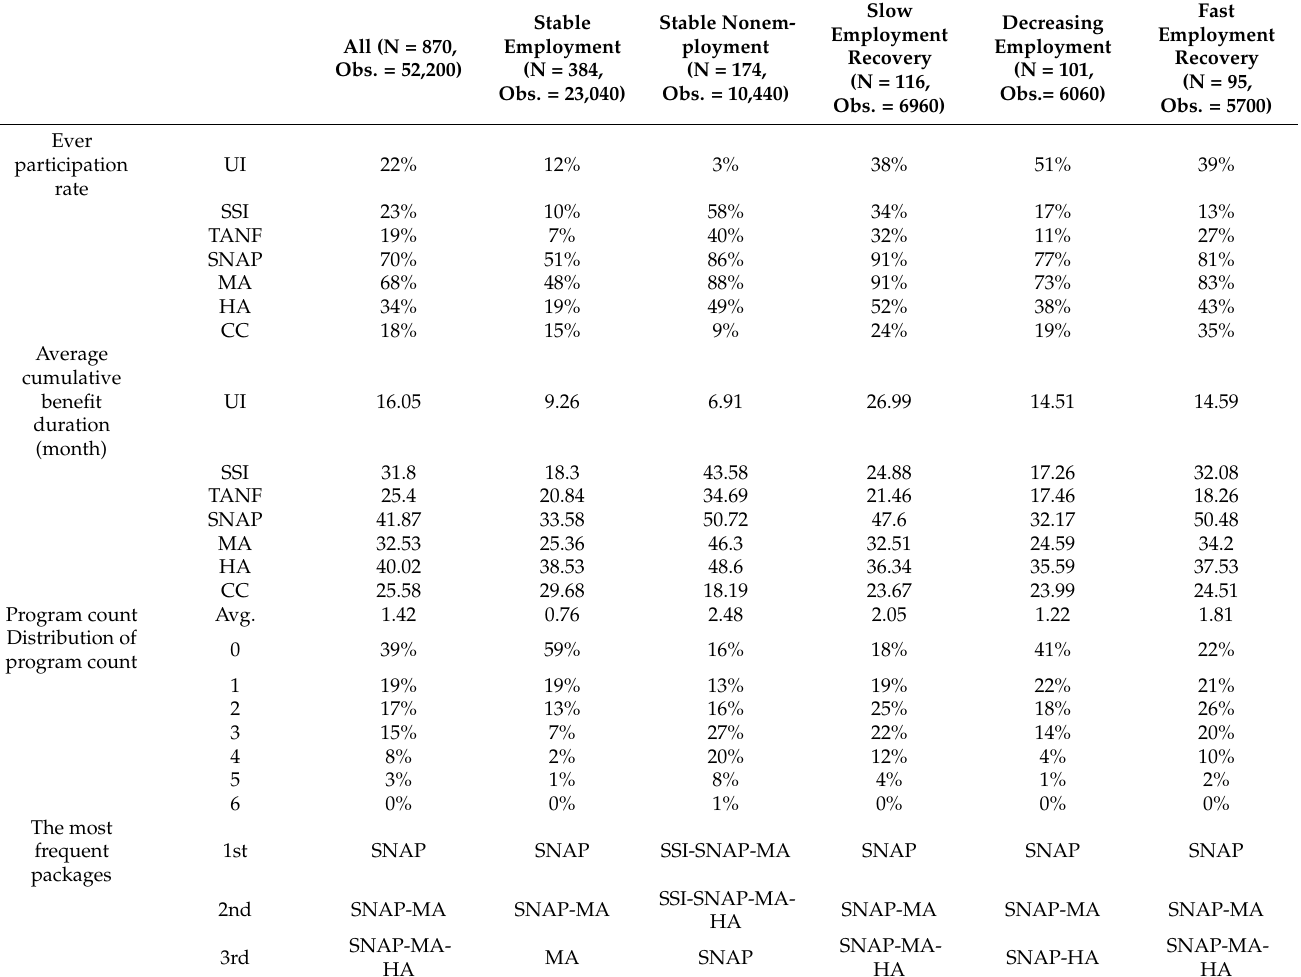
Table 1. Patterns of Program Participation for the Seven Benefit